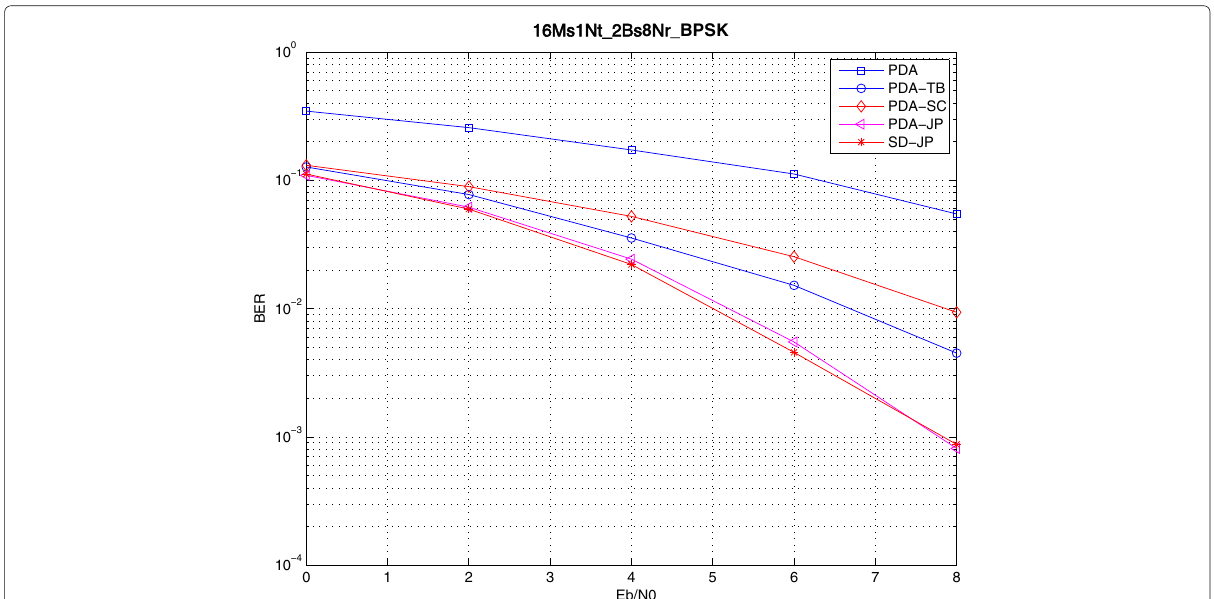
Fig. 3 BER performance with N m = 16 and N r =